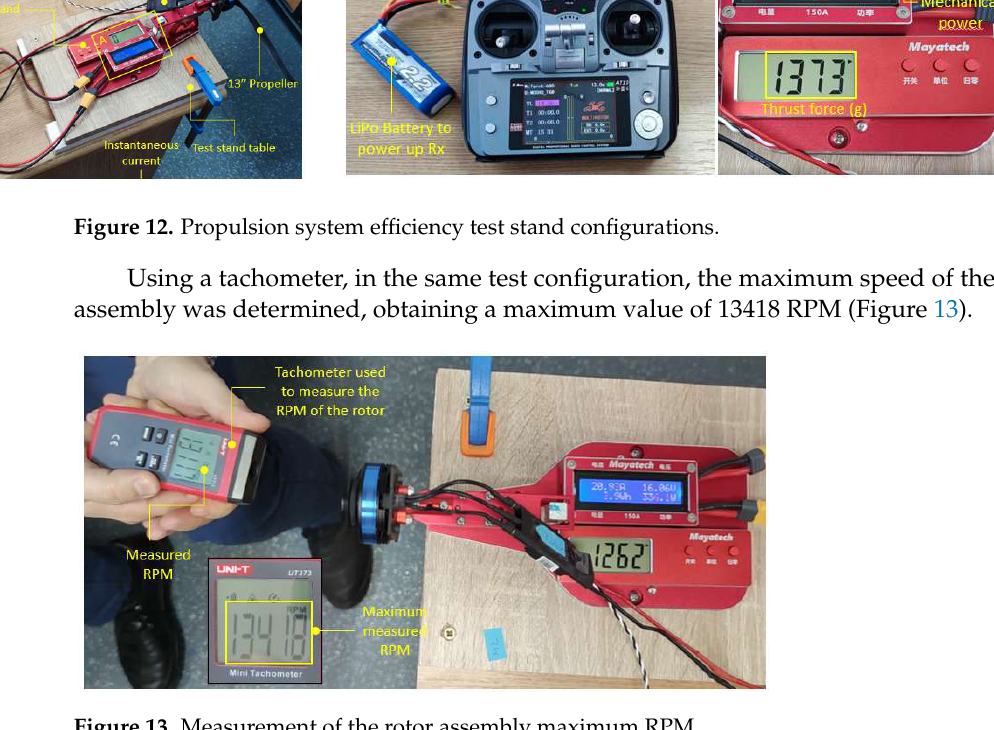
Figure 14. Propulsion system tests results. ( a ) Propulsion system efficiency; ( b ) Traction force as a function of RPM; ( c ) Current consumption based on RPM; ( d ) Mechanical power versus RPM; ( d ) Mechanical power versus RPM .